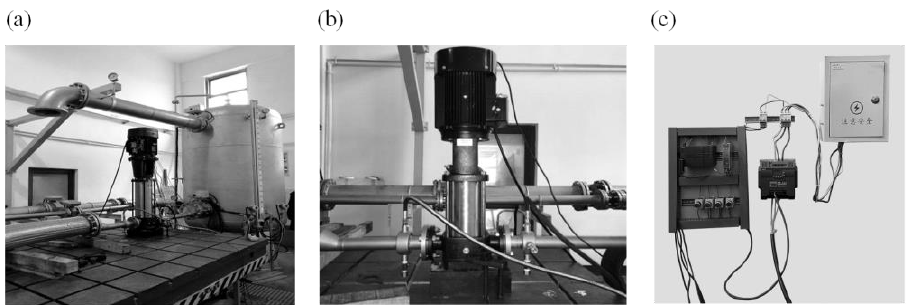
Figure 1. A closed-loop pump test system.